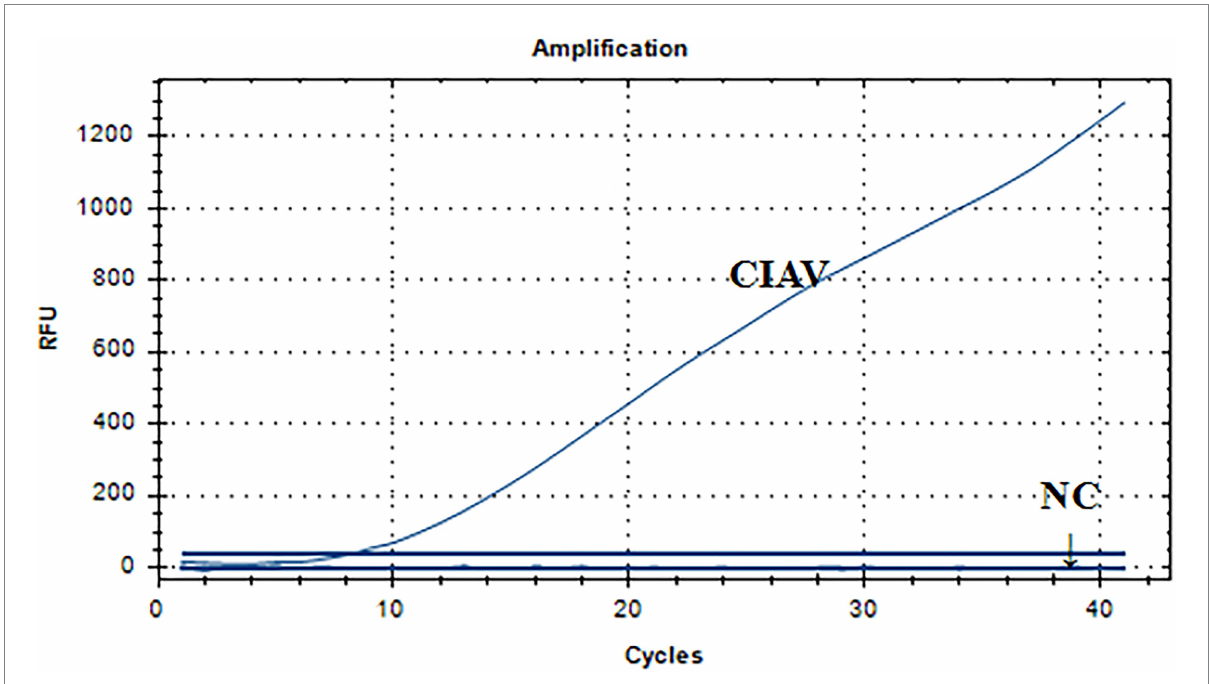
FIGURE 5 Specificity analysis of the real-time RAA assay for CIAV. The CIAV nucleic acid positive control had a single fluorescence signal curve. There was no fluorescence signal in the negative controls of ddH 2 O, H9N2, MDV, ALV, ILTV, IBV, NDV, REV, and IBDV nucleic acid. NC: negative control, i.e., ddH 2 O, H9N2, MDV, ALV, ILTV, IBV, NDV, REV, and IBDV nucleic acid. RAA, recombinase-aided amplification assay; MDV, Marek’s Disease Virus; CIAV, Chicken Infectious Anemia Virus; IBV, Infectious Bronchitis Virus; NDV, Newcastle Disease Virus; IBDV, Infections Bursal Disease Virus; H9N2,